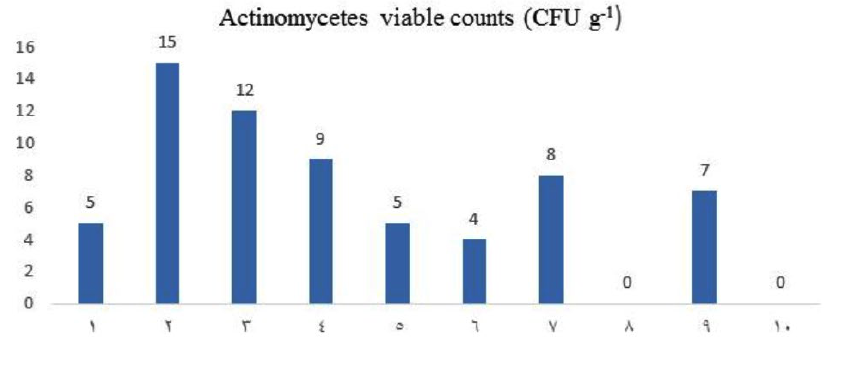
Fig. 2. Actinomycetes viable counts (CFU g-1) of mangrove soil samples during summer 2019 Table 2. Physicochemical characters of soil samples collected from mangrove area during Summer 2019 Physical-chemical parameters Sample